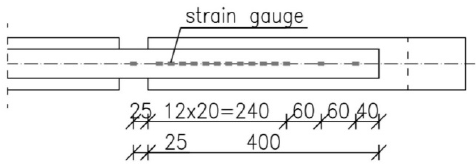
Figure 3. The arrangement of the strain gauges on the anchorage length of 400 mm.